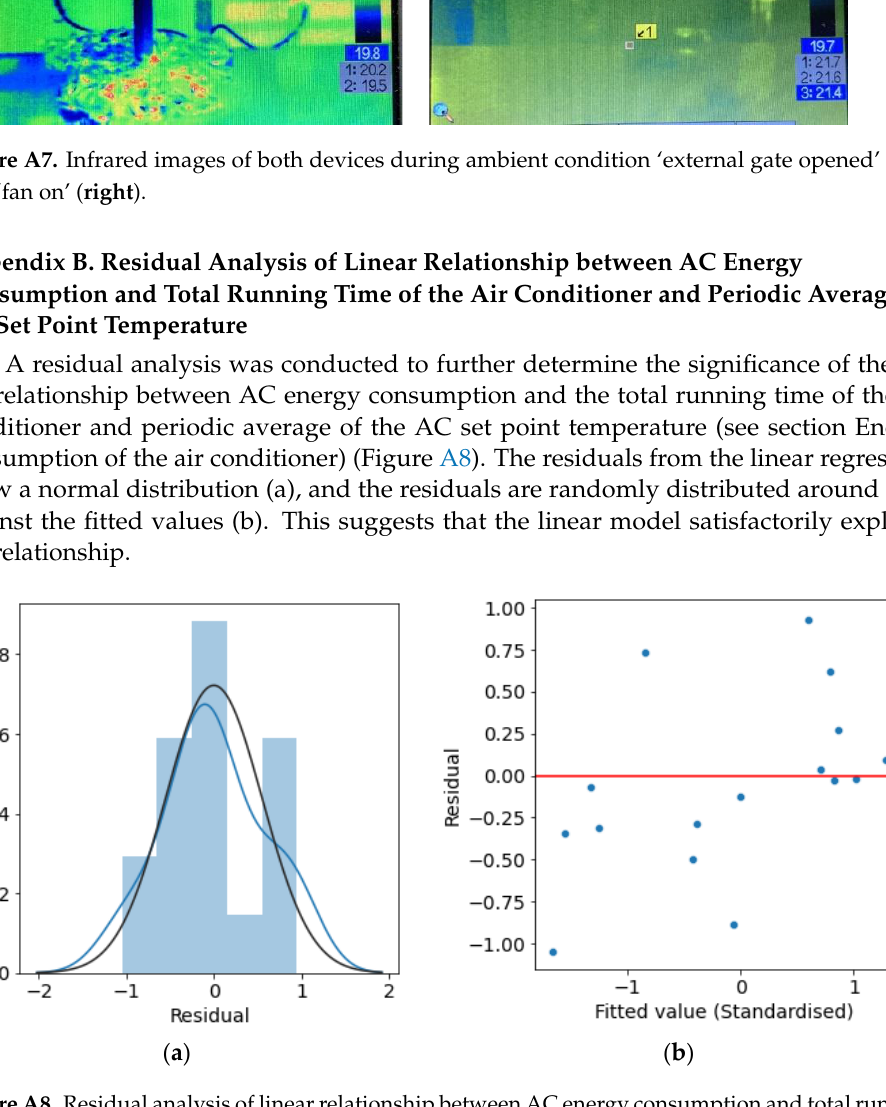
25 of 29 Figure A6. Difference in globe (tg) and mean radiant temperature (mrt) recorded by the Arduino prototype and Almemo instrument during various ambient conditions. Appendix A.4. Infrared Thermography Infrared images show the surface temperatures of both devices (Figure A7). Overall, the images show that the influence of localized heating due to the heat emitted from the micro-controller is negligible when the base of the prototype is covered with aluminium